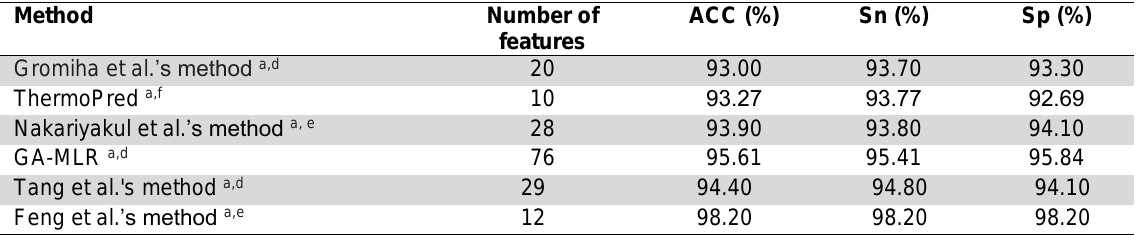
Table 4: Performance comparison of Gromiha et al.’s method, ThermoPred, Nakariyakul et al.’s method, GA-MLR, Tang et al.'s method and Feng et al.’s method on the Lin2011